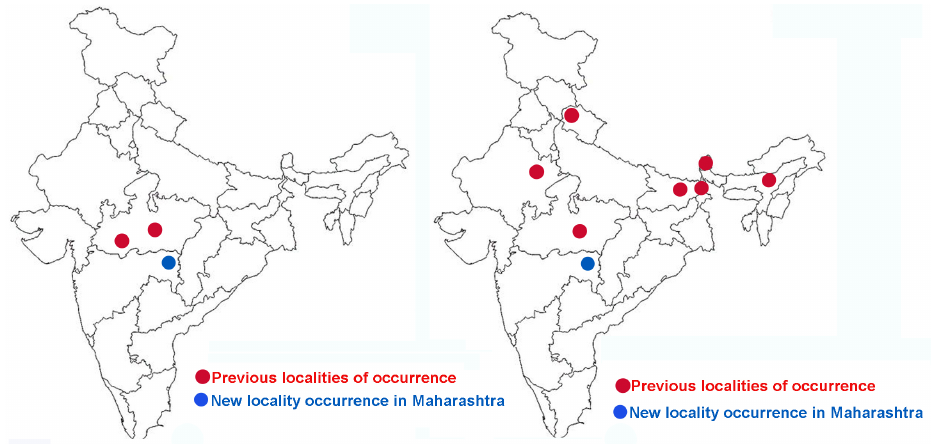
Figure 1. Map showing geographical distribution of (a) A. longiconnectivus , (b) A. margaritifer